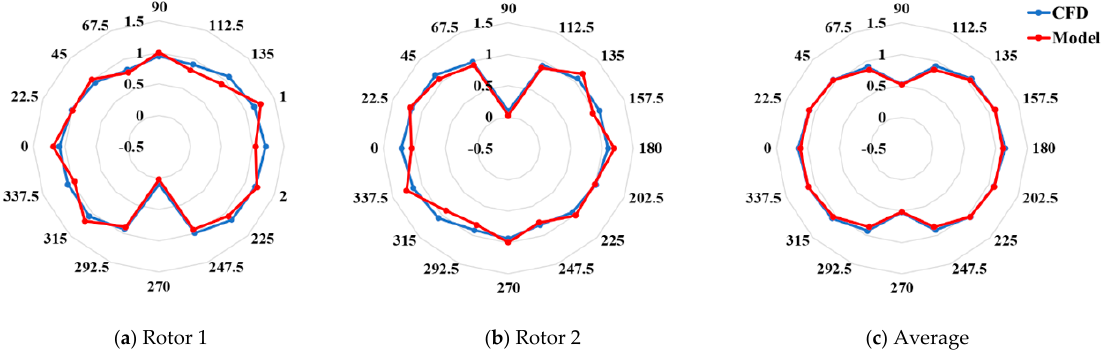
Figure 14. Distributions of normalized rotor powers in the IR − configuration in the case of gap = 0.5 D : ( a ) Rotor 1; ( b ) Rotor 2; ( c ) average.